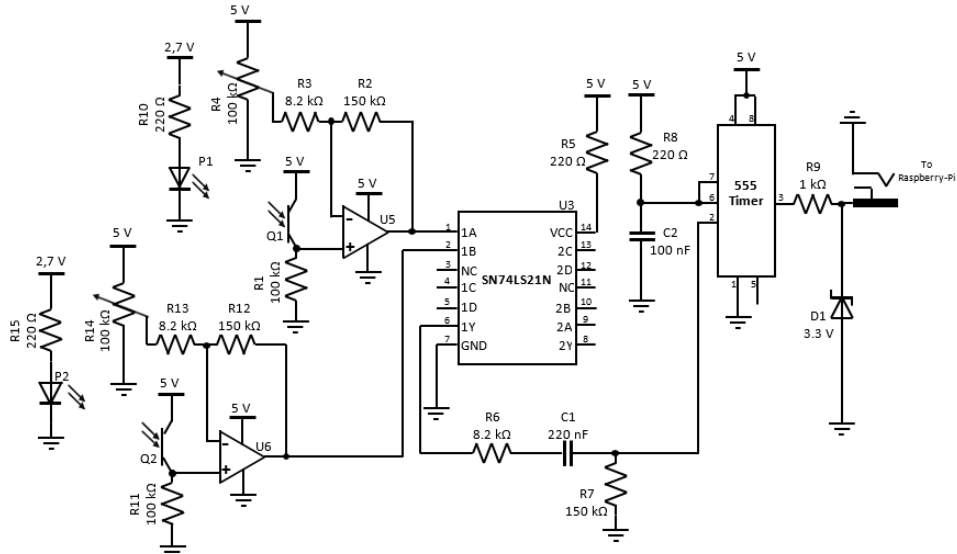
Figure 3. Schematic of the signal conditioning circuit reduced to only two IR sensors.